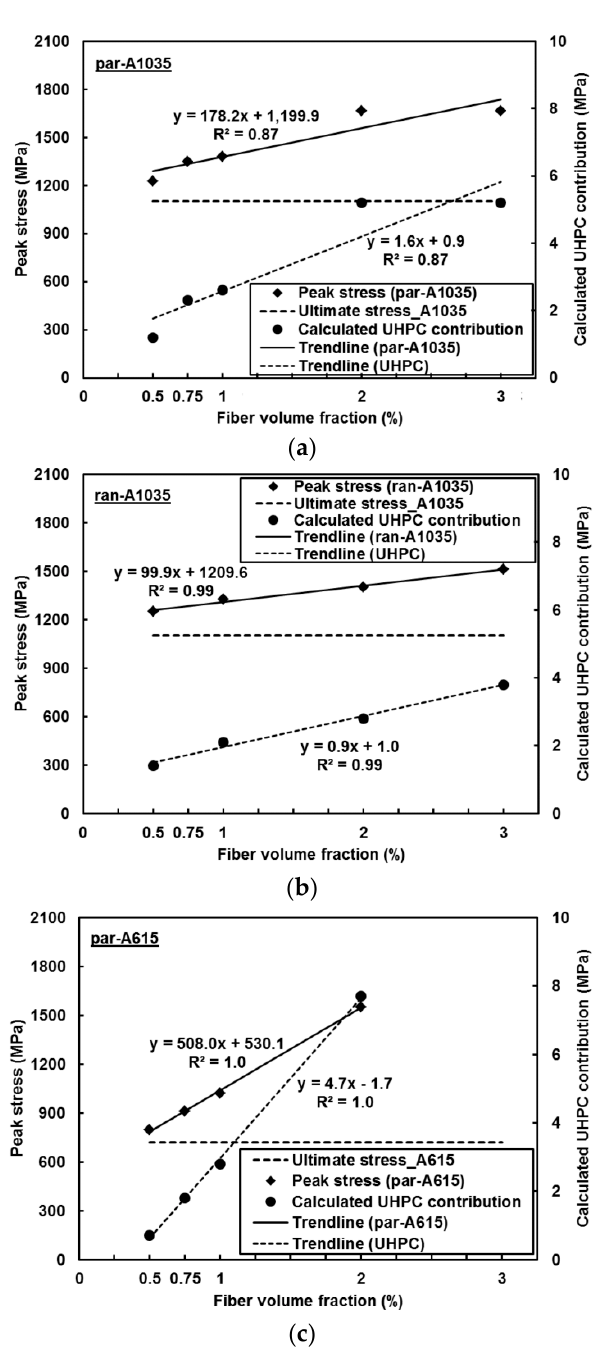
Figure 13. Effect of volume fraction on the peak stress of reinforced UHPC and on the UHPC contribution: ( a ) A1035 bars with parallel fiber orientation; ( b ) A1035 bars with random fiber orientation; ( c ) A615 bars with parallel fiber orientation.